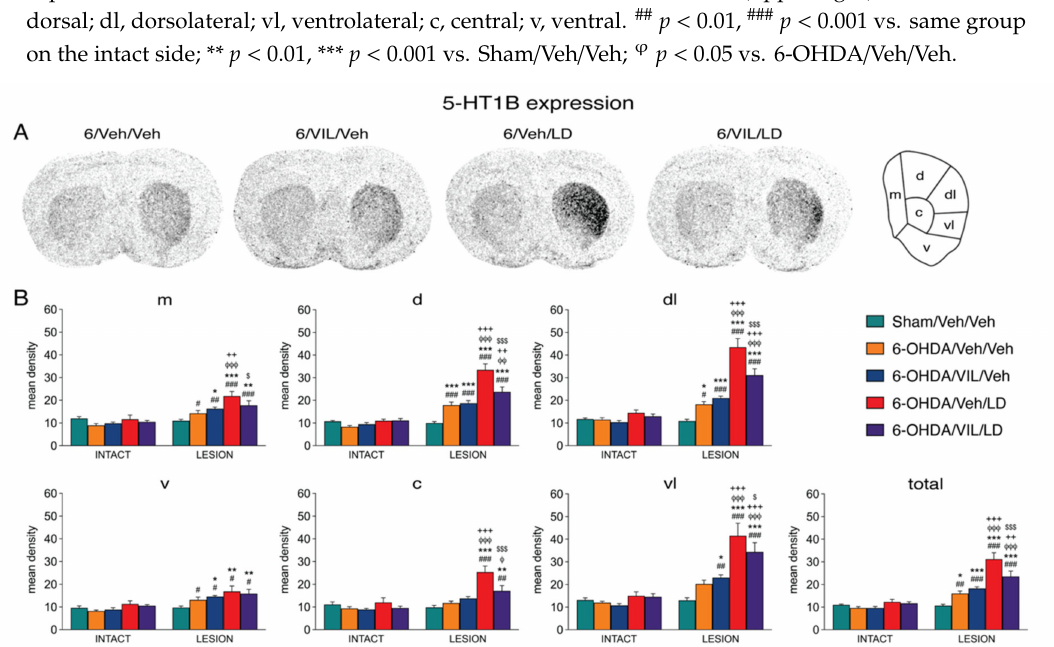
Figure 4. Vilazodone inhibited the L-DOPA-induced increase in 5-HT1B expression in the dopamine-depleted striatum. ( A ) Illustrations of film autoradiograms depict expression of 5-HT1B in sections from the mid-level striatum in rats with a 6-OHDA lesion (right hemisphere) followed by repeated vehicle (6-OHDA / Veh / Veh), vilazodone (10 mg / kg) + vehicle (6-OHDA / VIL / Veh), vehicle + L-DOPA (5 mg / kg) (6-OHDA / Veh / LD), or vilazodone + L-DOPA treatment (6-OHDA / VIL /